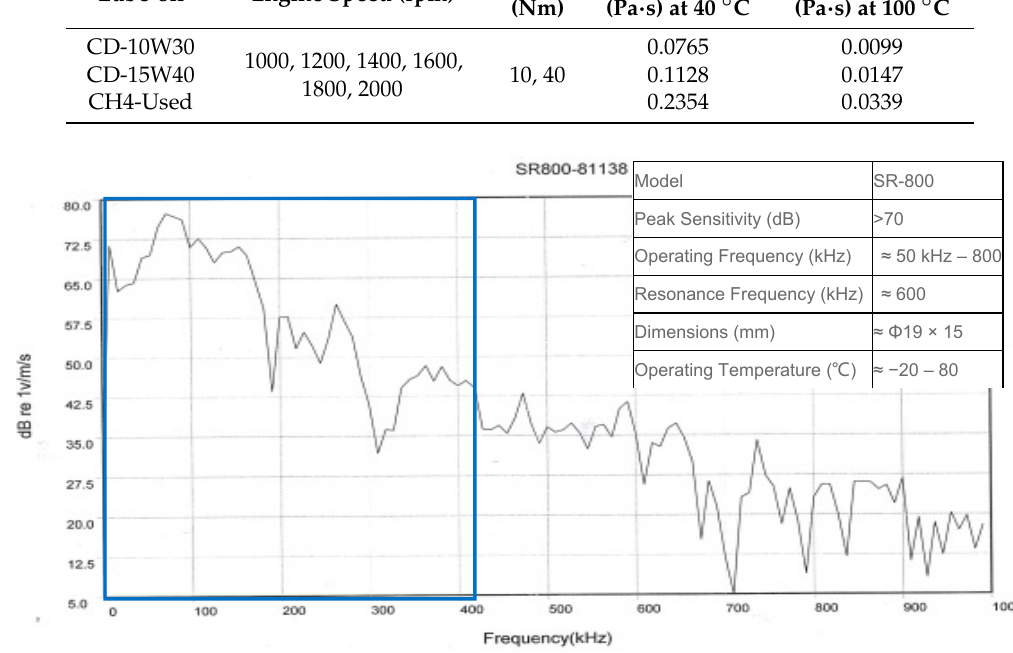
Figure 4. The frequency characteristic curve of the acoustic emission sensor SR800.